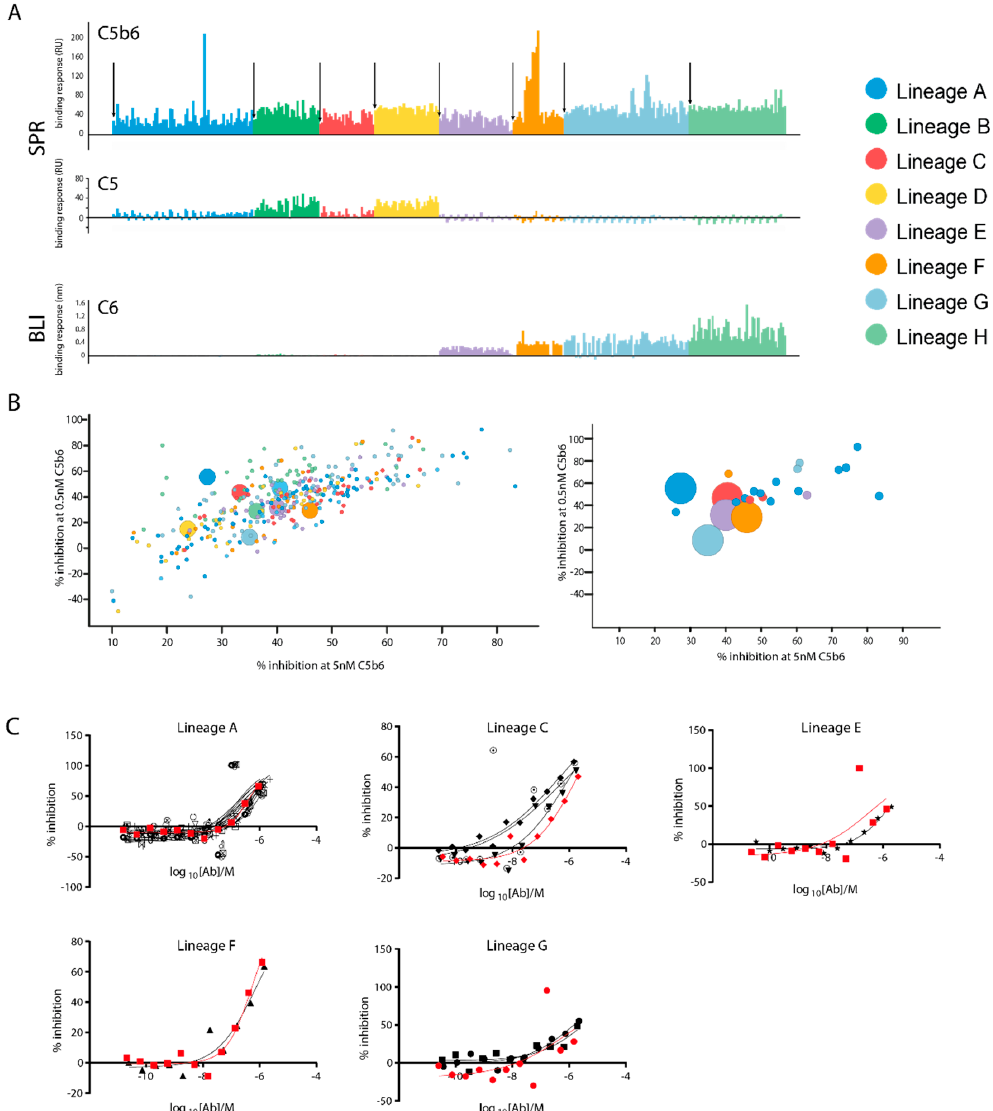
Figure 6. Characterisation of the affinity matured output. ( A ) Relative binding responses of affinity matured clones for the 3 antigens. C5 and C5b6 binding is measured by SPR using the capture method described in Figure 4, binding to C6 is measured by BLI. Clones are coloured by lineage and the parental clone, the first bar for each lineage, is highlighted with an arrow. The C5 and C5b6 binding responses are plotted on the same axis and not normalised for the relative molecular weights of C5 and C5b6. ( B ) % − inhibition in the C9-oligomerisation assay with 0.5 nM C5b6 and 2.5 nM C7 ( y − axis) and 5 nM C5b6 and 10 nM C7 ( x − axis). Each circle represents one clone, coloured by lineage. Parental clones are shown as larger circles. Right: A selection of 24 promising clones, from 5 lineages, to be further analysed in a dose − response HTRF assay. ( C ) Dose response curves of the 24 clones tested in the HTRF assay using 5 nM C5b6 and 10 nM C7, grouped by lineage, with parental clones highlighted in red.